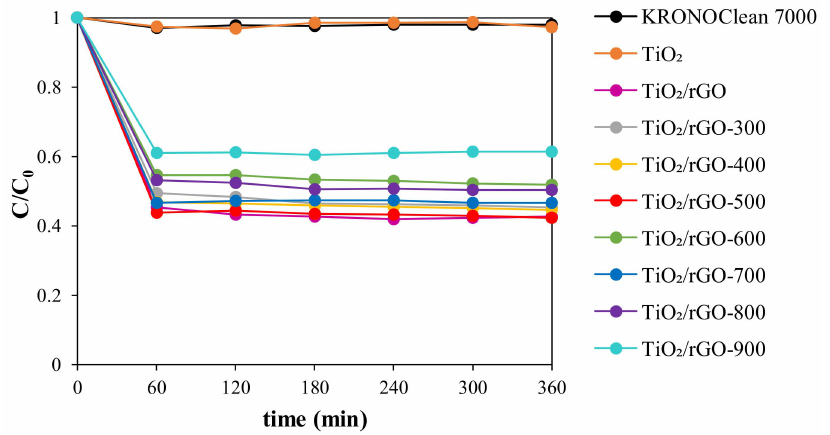
Figure 9. Methylene blue adsorption on the surfaces of reference, control, and prepared